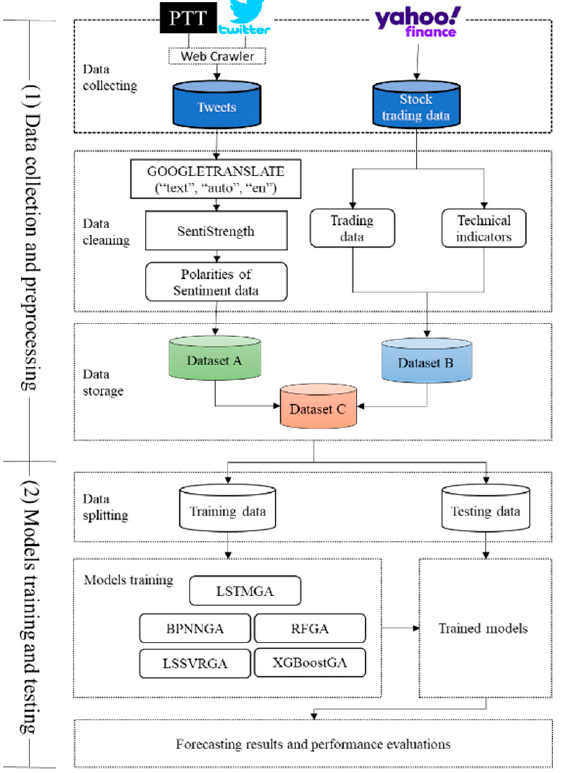
Figure 2. The flowchart of this study.